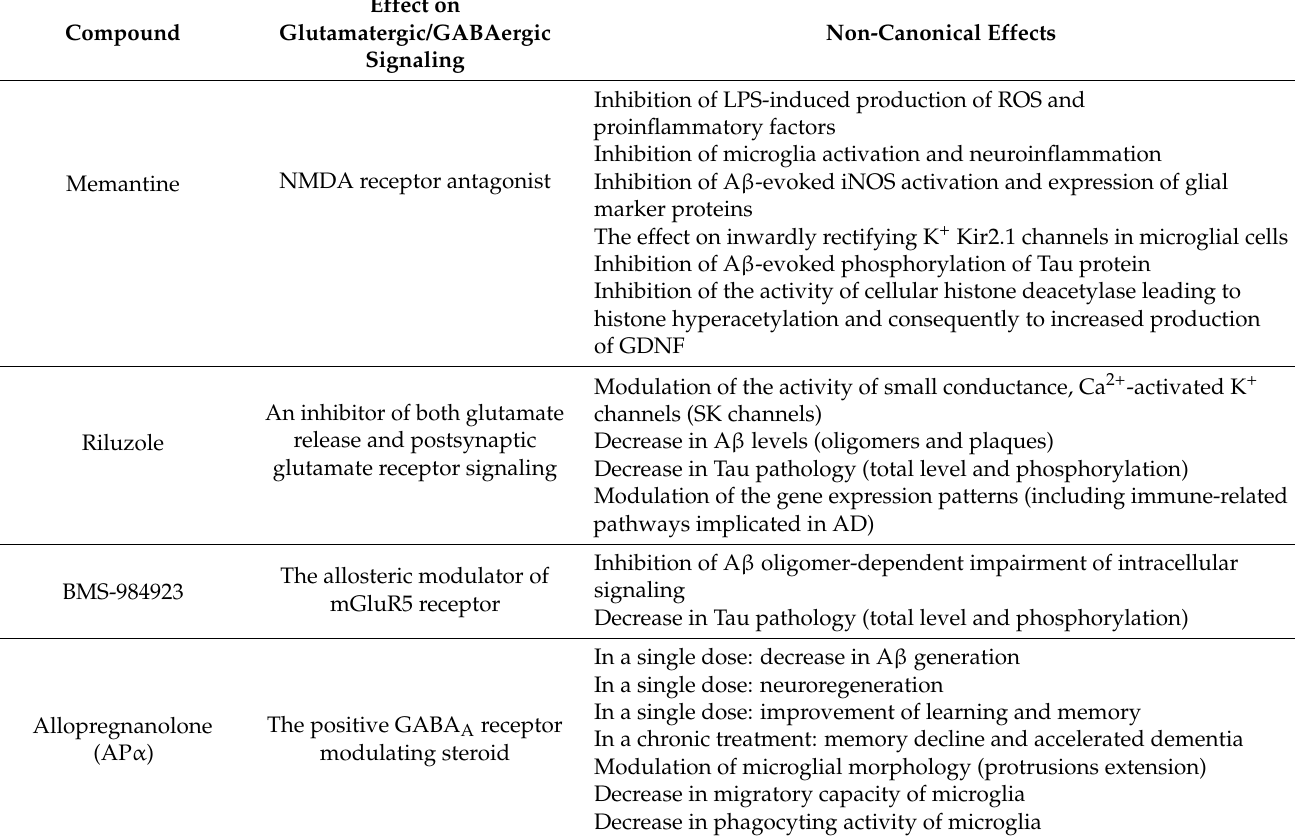
Table 3. Pharmacological compounds affecting glutamatergic/GABAergic signaling in Alzheimer’s disease.